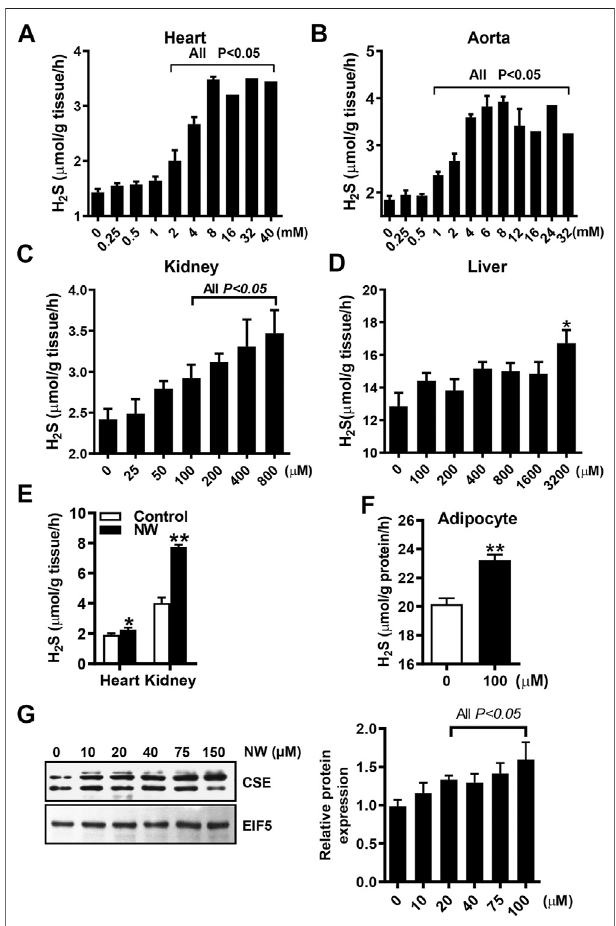
FIGURE 3 | NW improved CSE/H 2 S production. L-Cysteine and pyridoxal phosphate and indicated concentration of NW are added to tissue homogenates. H 2 S production in the heart (A) , aorta (B) , kidney (C) , and liver (D) was measured, N (cid:2) 4. SD rats were subcutaneously injected with NW 4.4 mg/kg/day for 1 week. H 2 S production in the heart and kidney was detected (E) ,N (cid:2) 5.Inprimaryadipocytes, theeffect of100 μ MNWtreatment onH 2 Sproductionwasdetected (F) ,N (cid:2) 5.Incultured HepG2cells,theeffect of different concentrations of NW on the CSE protein level was detected. The left panelisrepresenting graph,and theright panel isstatistical graph (G) , N (cid:2) 3. ** p < 0.01.